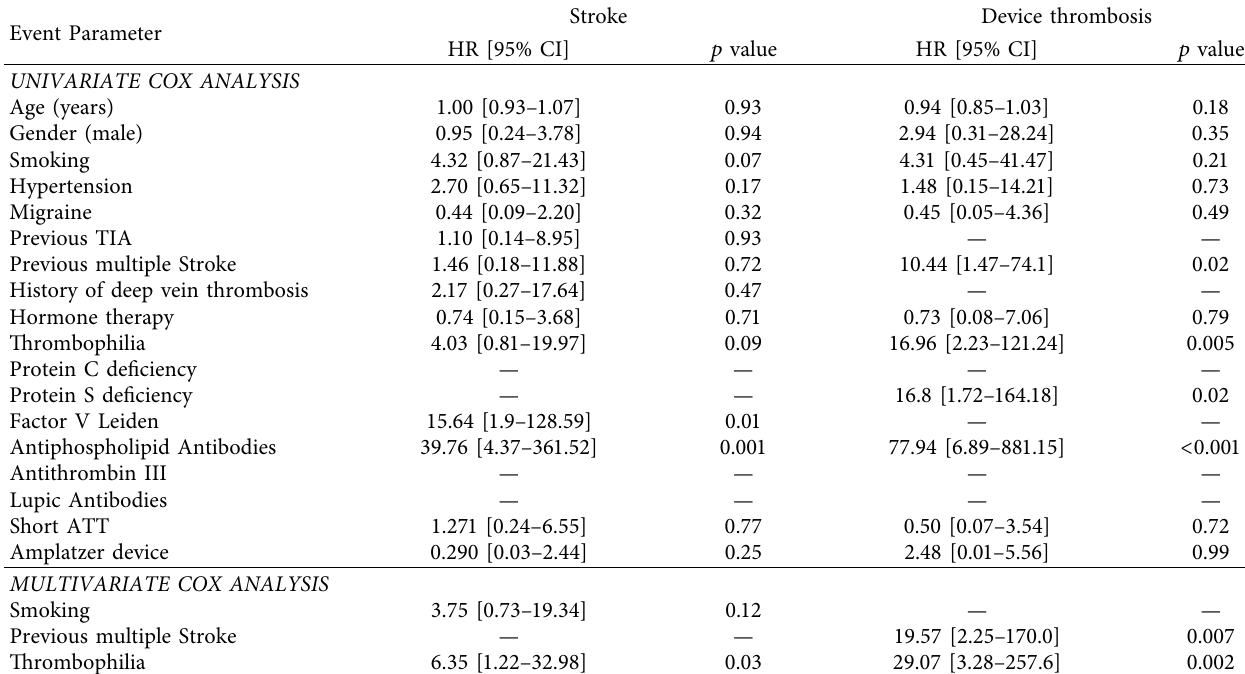
Table 6: Univariate and multivariate analysis for predictors of stroke and device thrombosis according to Cox models. Event